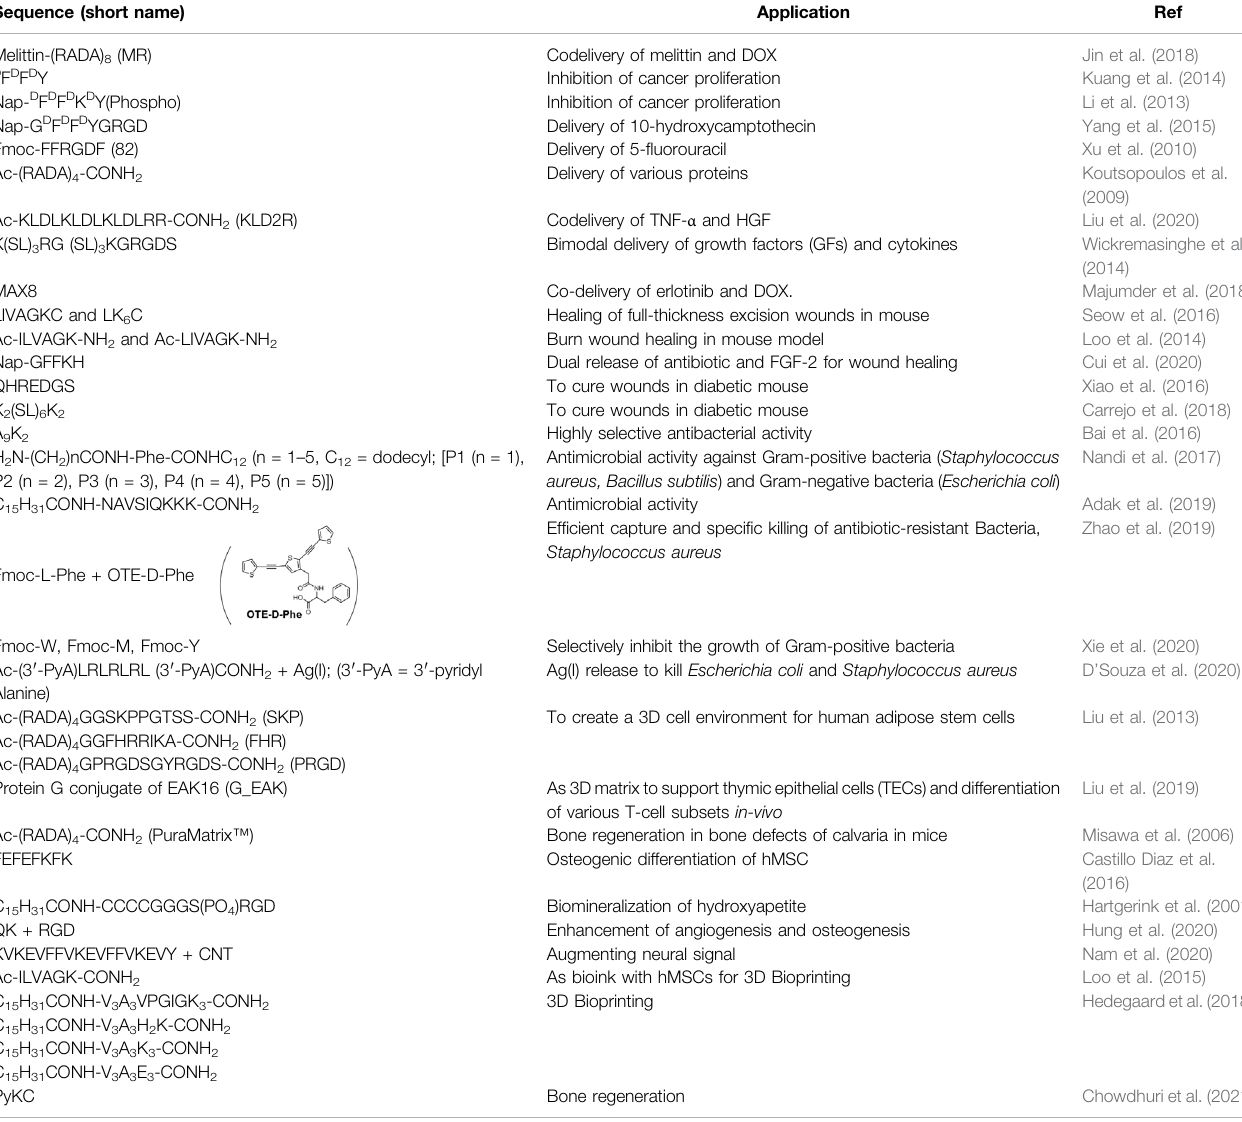
TABLE 3 | Examples of peptide hydrogels used for therapeutic